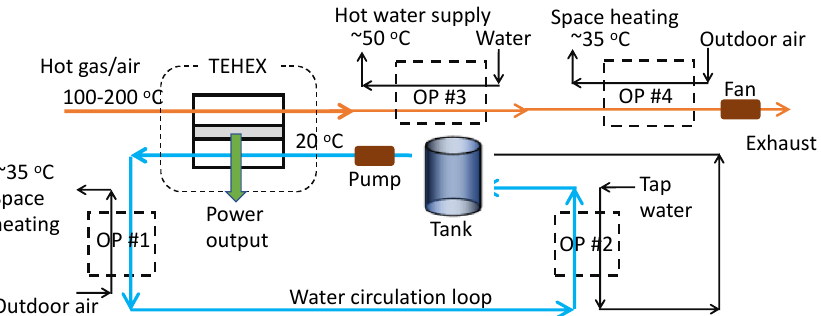
Figure 2. Conceptual CHP system with a thermoelectric integrated heat exchanger (TEHEX) where the thermoelectric legs generate electrical power. There is a set of options (#1 and #2 heat exchangers) for heat energy harvesting for the cooling water loop. Also, there is another set of options (#3 and #4 heat exchangers) for the exiting gas that remains low-grade heat but at a sufficient temperature for generating hot water, preheating tap water for a boiler, or space heating. Note that pump and fan are the components that require some electrical power input; thus, there is a tradeoff in obtaining net power output from the TE system.